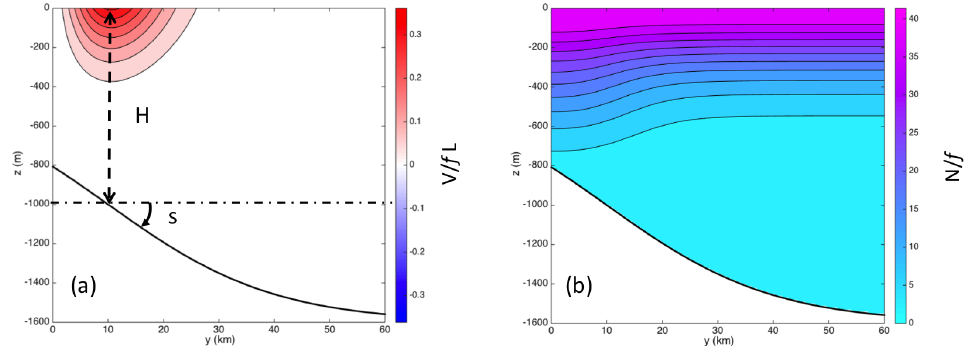
Figure 1. Simplified configuration of a surface coastal current above an hyperbolic tangent bathymetry. The along-shore velocity (a) and the Brunt–Väisälä frequencies (b) are plotted in dimensionless form ( V/f L, N/f ) and correspond to the configuration where H = 1000m, L = 10km, s = 3%, (cid:49)T jet = 0 . 8 ◦ C, U max = 35cms − 1 , f = 1 . 26 × 10 − 4 s − 1